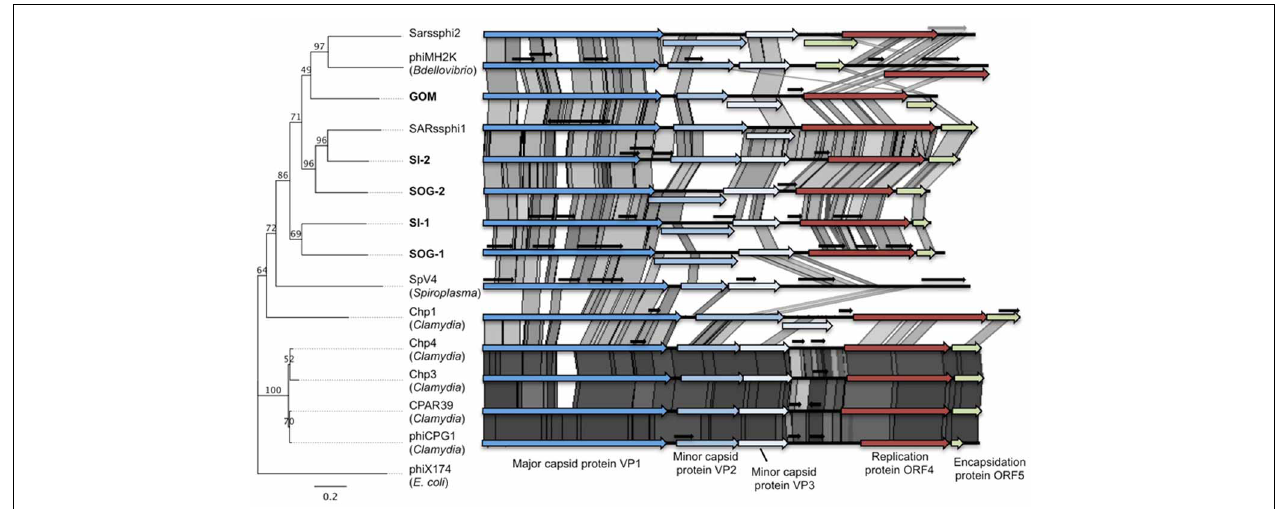
FIGURE 1 | Gokushoviruses share a similar genome organization. Whole genome phylogeny (Maximum likelihood, 100 bootstrap replicates, HKY85 model) on the ORFs of gokushoviruses rooted with the microvirus phiX174 (left) and pairwise comparisons of the five environmental gokushovirus genomes assembled from this study (bold) with the isolates and other